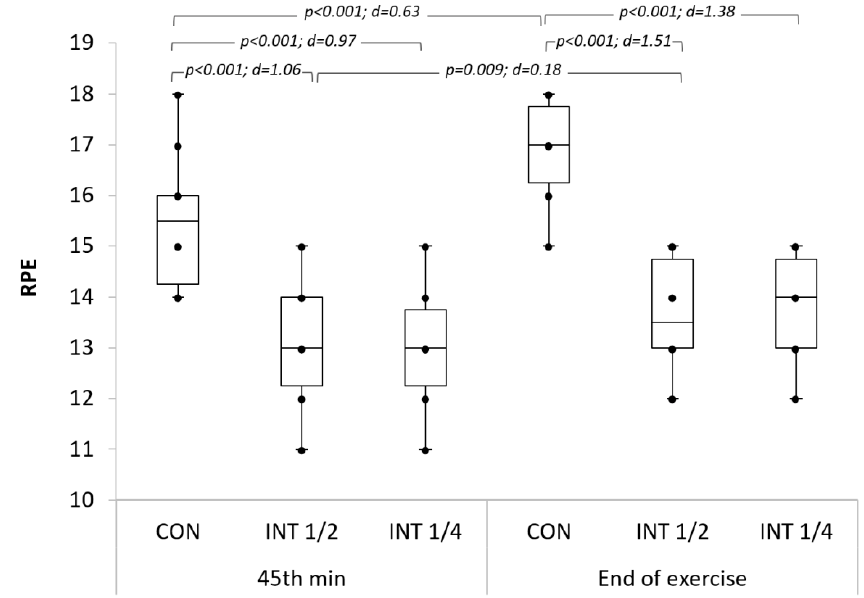
Figure 2. RPE at the 45th minute and at the end of the three exercise types ; d: Cohen’s d.